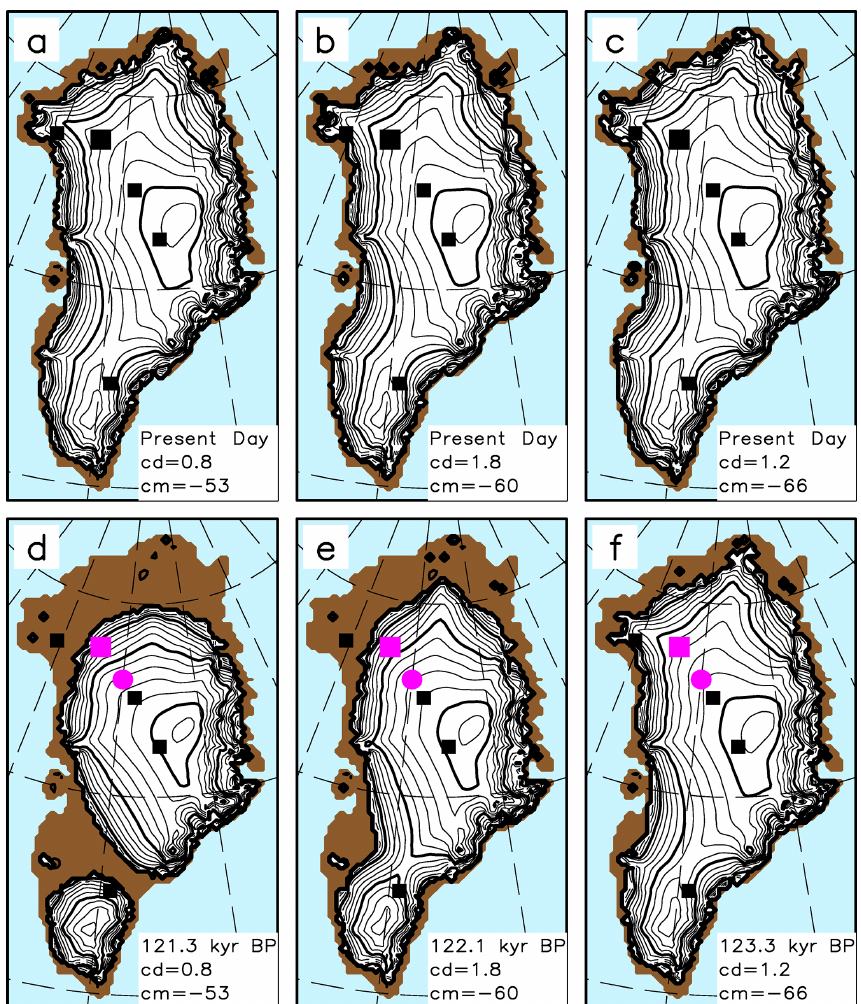
Figure 7. Present-day ( a – c ) and Eemian ( d – f ) surface topography for varying melt and discharge parameters. Simulations correspond to those giving high medium and low contributions to Eemian sea-level rise (2.5, 1.5 and 0.6m), respectively. The Eemian snapshots correspond to times with the simulated minimum ice volume during the Eemian for the respective simulation. NEEM locations are marked in magenta (square for borehole and circle for